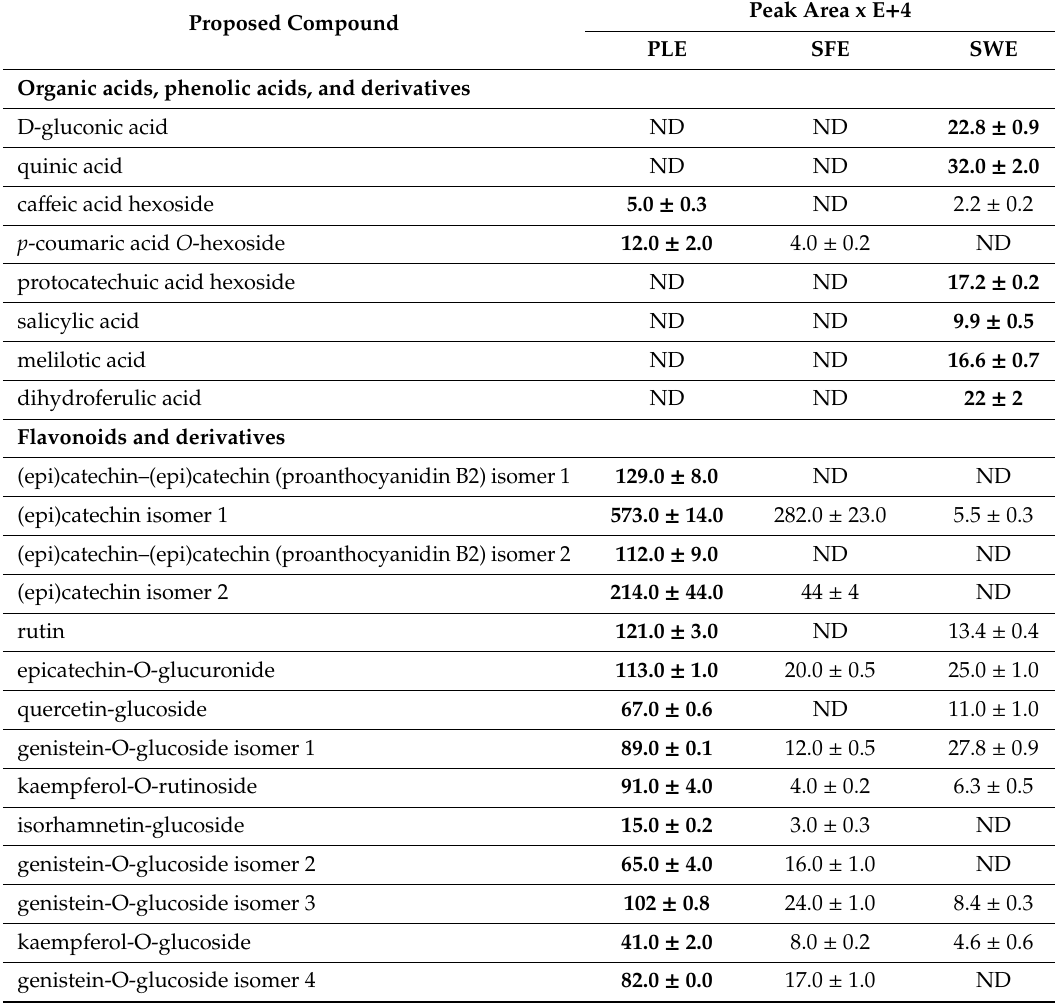
Table 2. Relative peak areas of the identified compounds in SC stem extracts expressed as mean ± standard deviation of the three analyses replicates (ND: non-detected compound). For each compound, the best extractive technique is marked in bold format. PLE: pressurized liquid extraction, SWE: subcritical water extraction, SFE: supercritical fluid